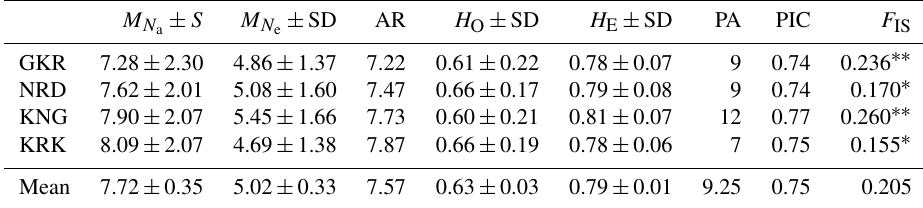
Table 2. Descriptive statistics for genetic diversity of each sheep population over 21 loci.